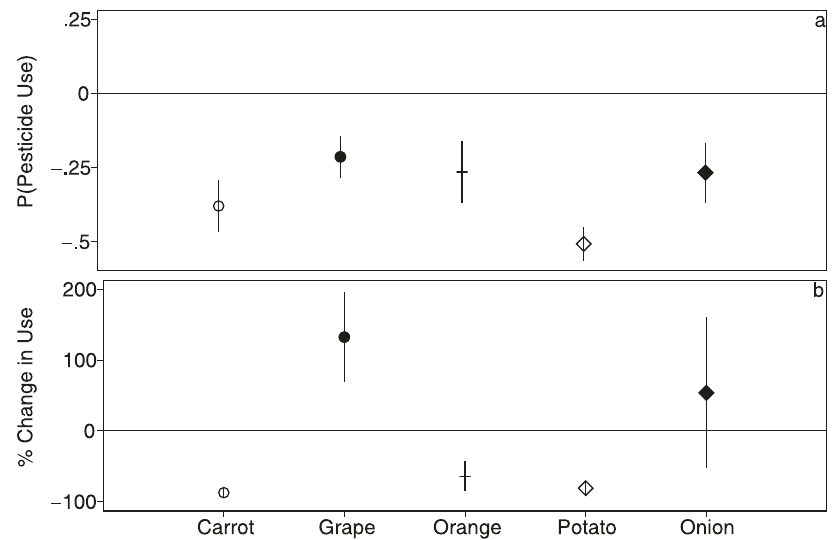
Fig. 3 Lognormal hurdle models run separately for 5 commonly grown organic and conventional crops. Across all fi ve crops, organic fi elds have a lower probability of using any pesticide active ingredients ( a ). The effect of organic on pesticide use for fi elds that do spray is crop-dependent ( b ). For the second hurdle ( b ), percent change is calculated from the log-level model as 100 ð e β (cid:2) 1 Þ and standard errors are derived using the delta-method implemented with the nlcom function in Stata. Symbols indicate point estimates (mean) and error bars represent the 95% CI. All models include heteroskedasticity robust standard errors. All models include covariates for fi eld size, farm size, and soil quality, as well as year random intercepts. For the fi rst hurdle, N = 4289 (Carrot), N = 8760 (Grape), N = 4654 (Orange), N = 2804 (Potato), N = 1126 (Onion). For the second hurdle, N = 2766 (Carrot), N = 7678 (Grape), N = 4316 (Orange), N = 2059 (Potato), N = 814 (Onion). Coef fi cient estimates for all covariates are provided in Supplementary Table